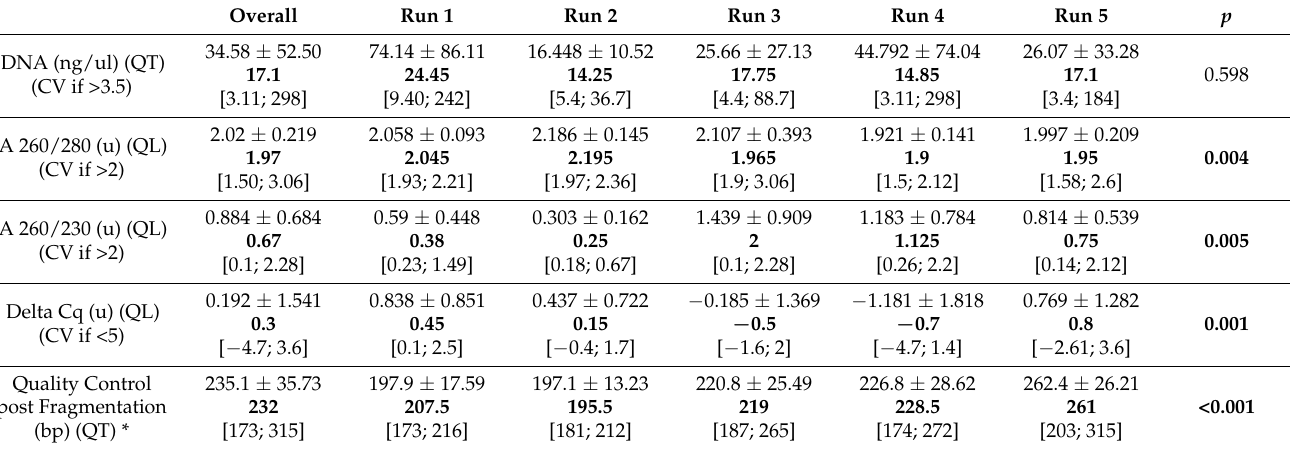
Table 1. DNA wet quality metrics. Quality metrics values, for each run, are reported as mean ± stan- dard deviation and median [range] of the 71 DNA samples. A Kruskal–Wallis test is used to evaluate the null hypothesis of the equality of the medians among the runs. Median values are reported in bold. p -values ( p ) below 0.05 are considered